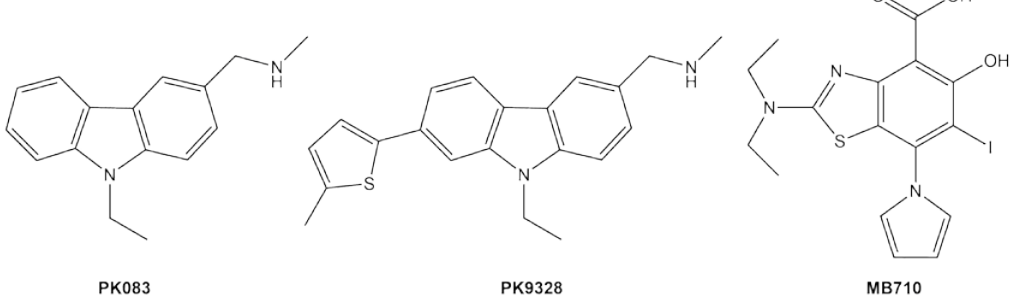
Figure 2. Cavity-binding compounds that target the stability class Y220C p53 mutant.